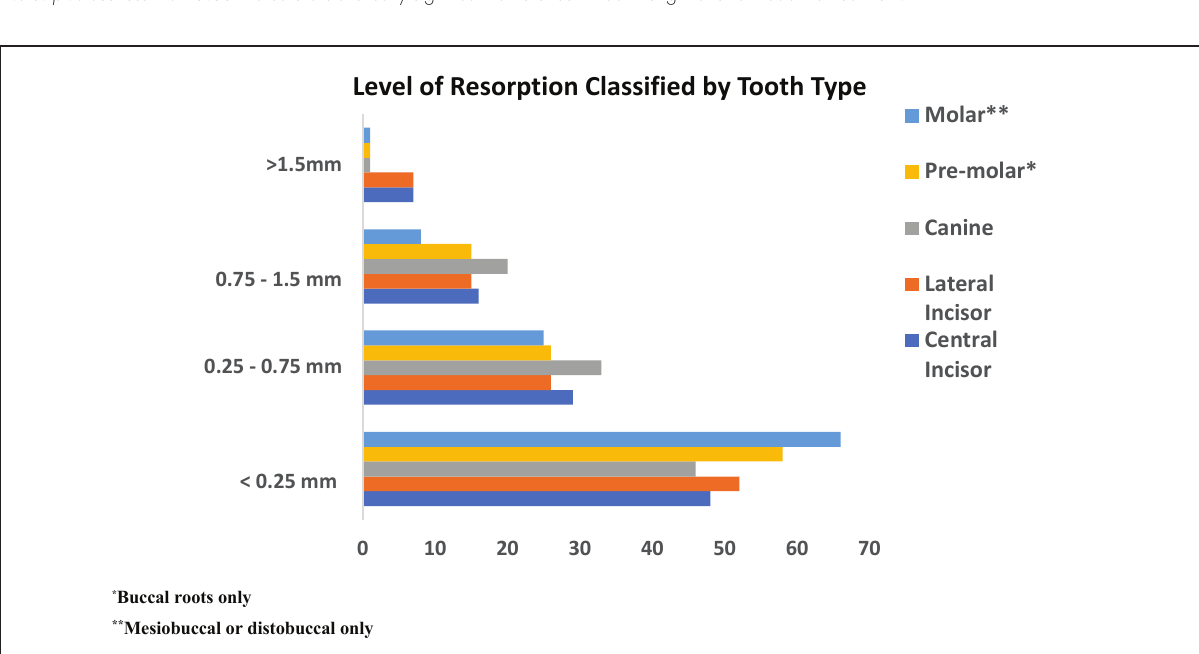
Figure 3. Level of resorption by